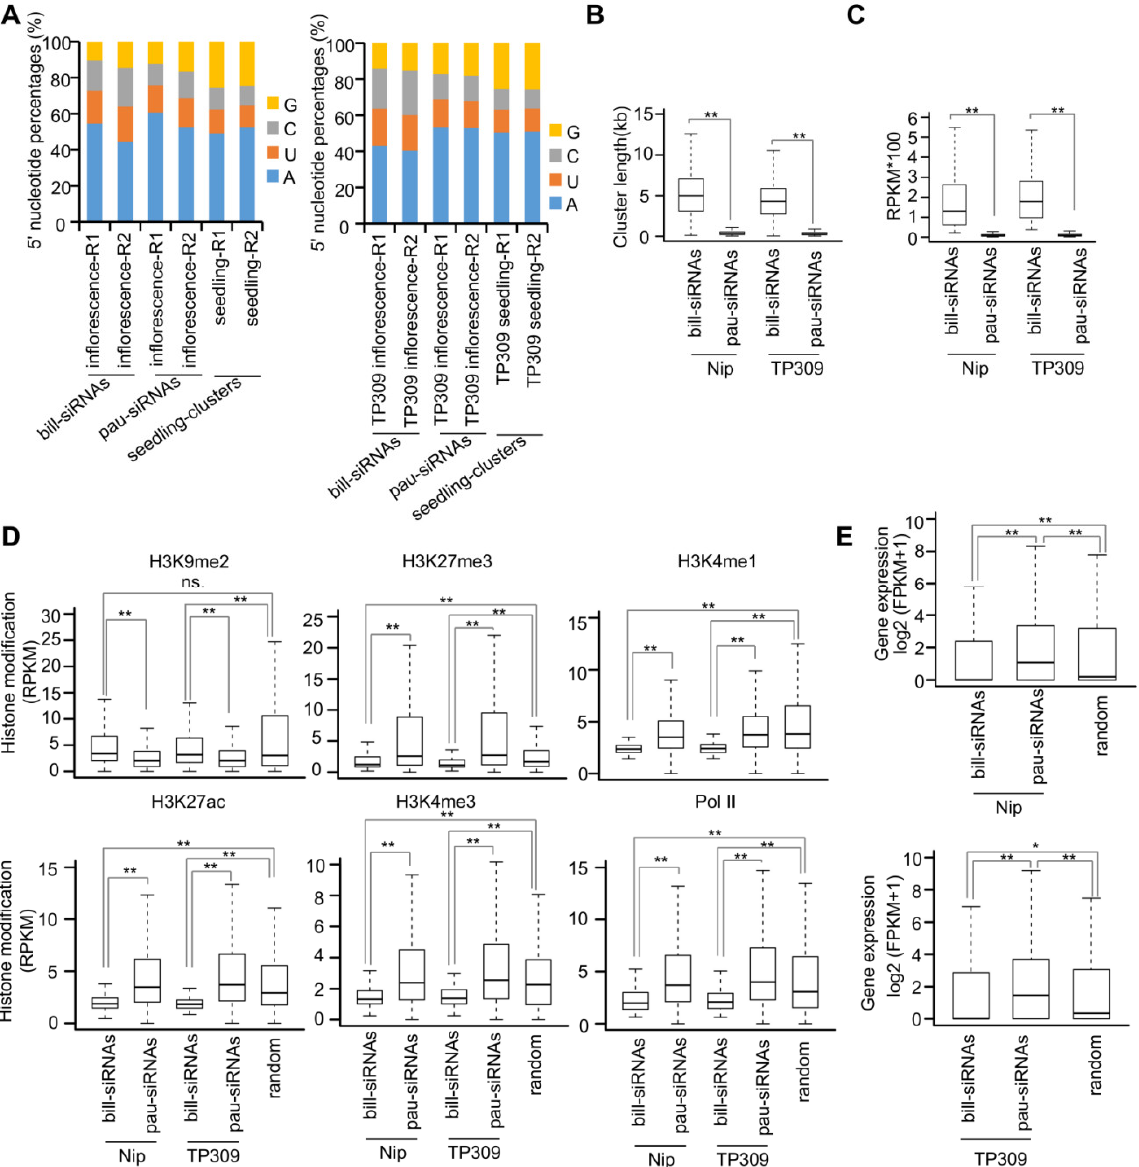
Figure 2. Characteristics of bill-siRNAs in inflorescences. ( A ) Percentage of four bases on the first nucleotide acid of bill-siRNAs and pau-siRNAs. ( B ) Lengths of bill-siRNA clusters and pau-siRNA clusters in Nipponbare and TP309. ** indicates p < 0.01 by the Wilcoxon sum test. ( C ) Relative abundance of bill-siRNA clusters and pau-siRNA clusters in Nipponbare and TP309. ** indicates p < 0.01 by the Wilcoxon sum test. ( D ) Comparison of histone modification of H3K9me2, H3K27me3, H3K4me1, H3K27ac, and H3K4me3, and Pol II occupancy on bill-siRNA clusters and on pau-siRNA clusters. A total of 20,000 randomly selected 350 bp regions were analyzed and served as control. ** indicates p < 0.01, and ns indicates not significant by the Wilcoxon sum test. ( E ) Comparison of expression level of bill-siRNA cluster- and pau-siRNA cluster-adjacent genes in Nipponbare and TP309. Three hundred randomly selected genes served as controls. ** indicates p < 0.01, and * indicates p < 0.05 by the Wilcoxon sum